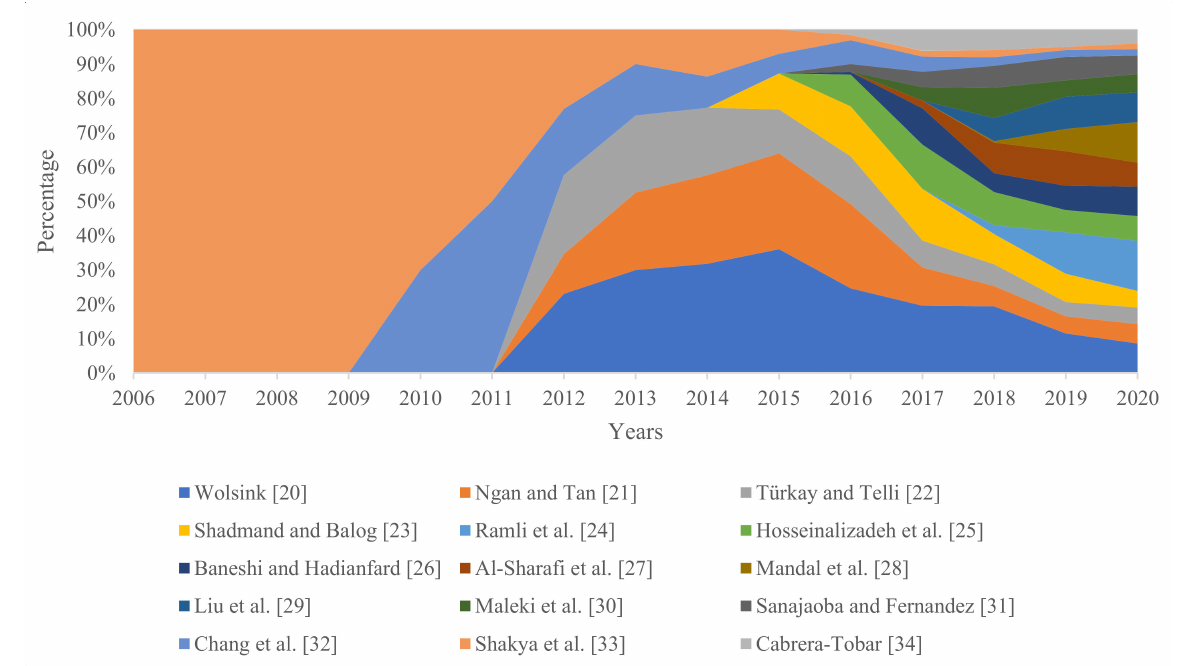
Figure 5. Evolution of article citations over the